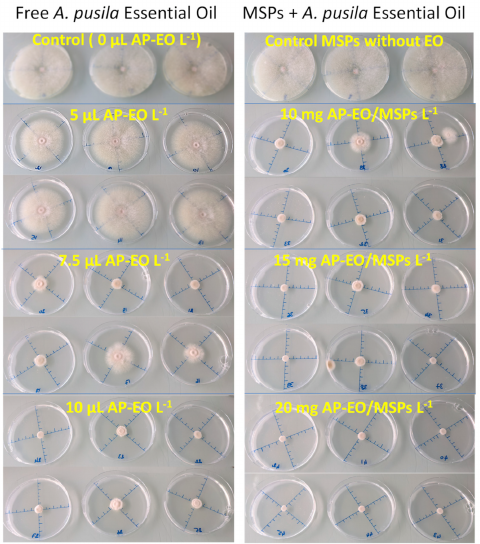
Figure 10. Effects of the volatile compounds released from AP-EO and AP-EO/MSPs on the mycelial growth of F. avenaceum incubated for 10 days at 25 ◦